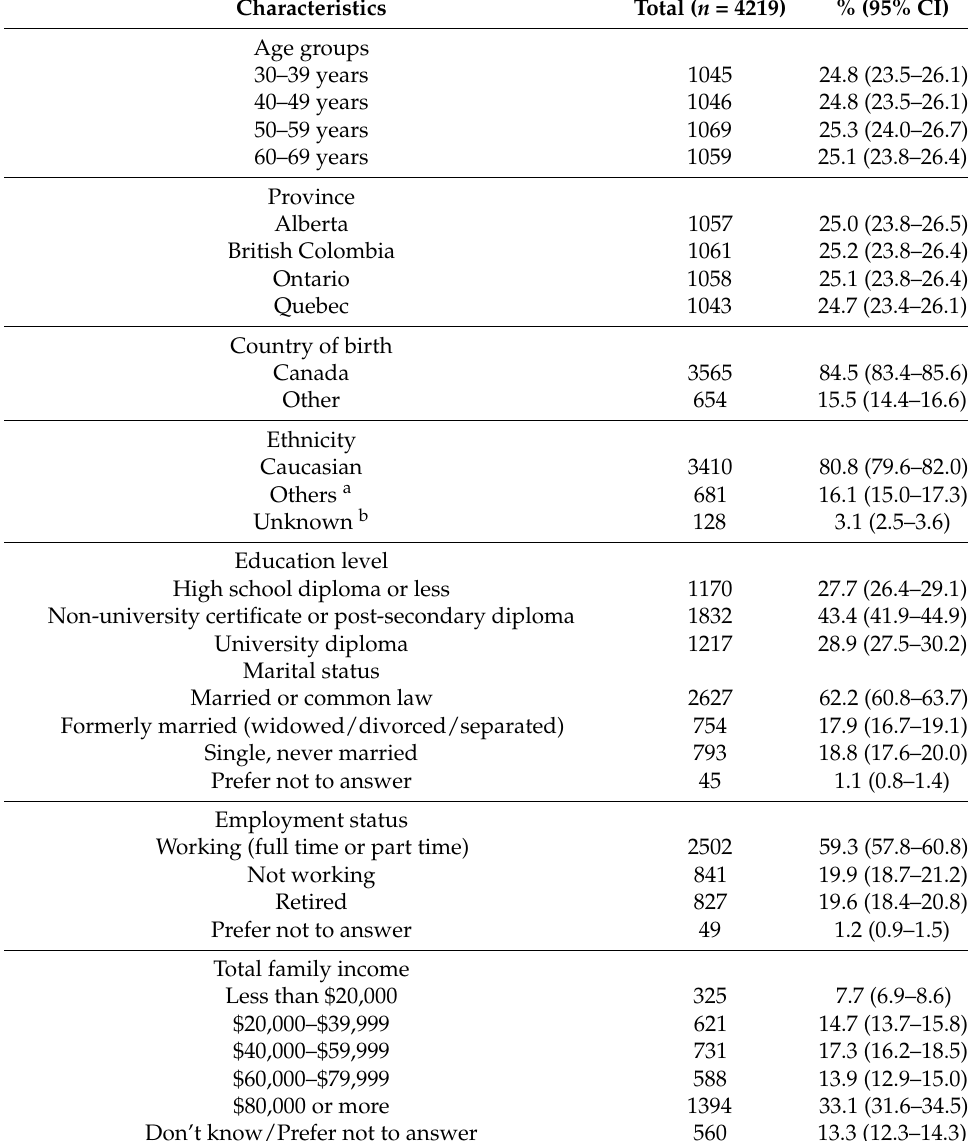
Table 1. Characteristics of the study